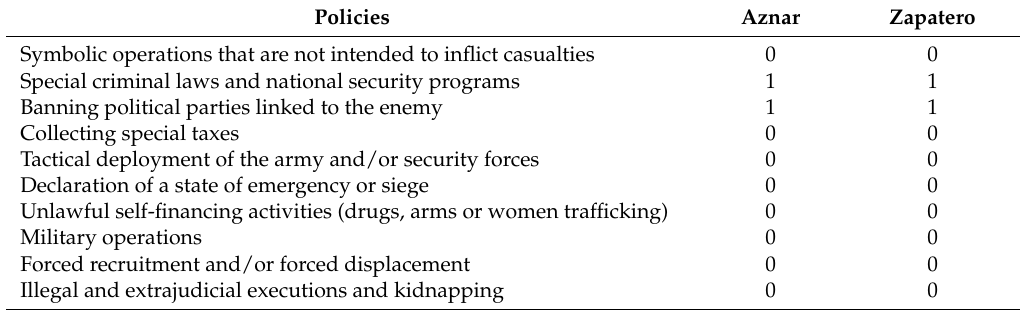
Table 7. Aznar’s (Suspicious) (1996–2004) and Zapatero’s (Administrator) (2004–2011) Peace Policies. Policies Aznar Zapatero Proposing neutral mediators